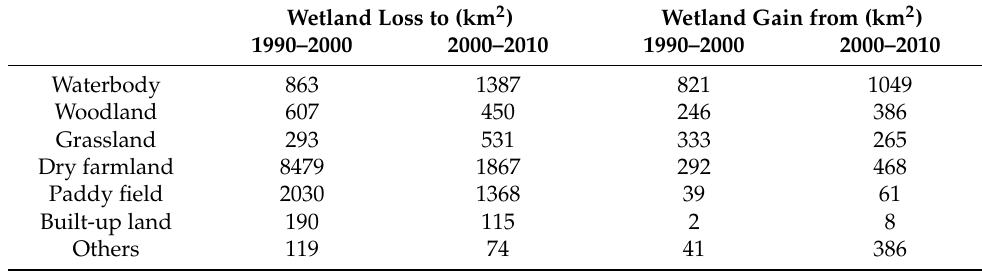
Table 6. Areal extents and conversions between wetland and other land